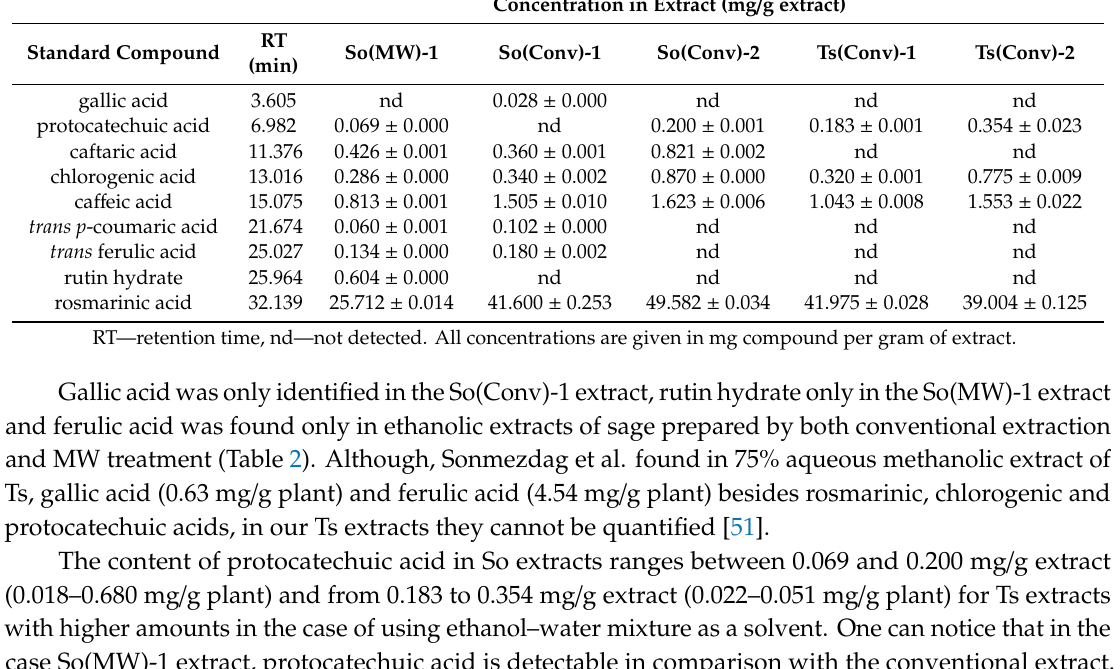
Table 2. Identification and quantification of polyphenolic compounds by reverse phase HPLC-PDA. Concentration in Extract (mg / g